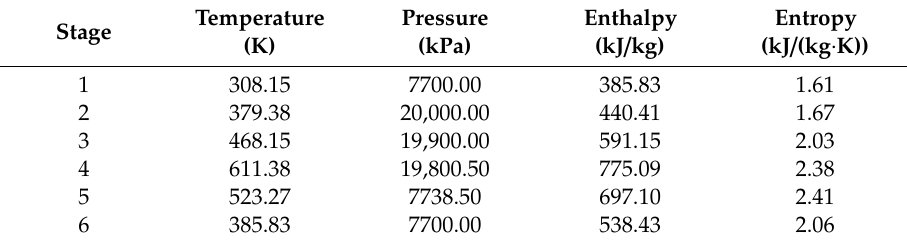
Table 3. Parameters describing S-CO 2 cycle presented in Figures 2 and 3.